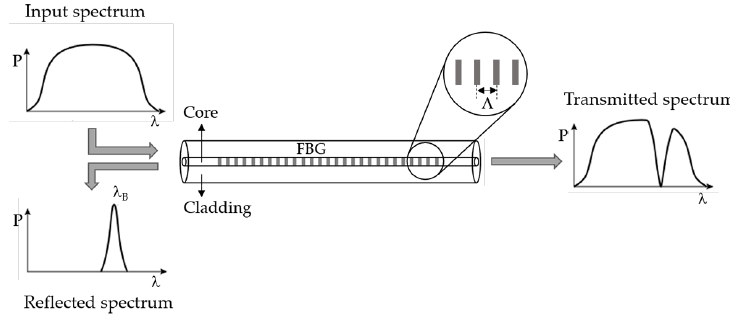
Figure 2. Schematic representation of the working principle of an FBG.